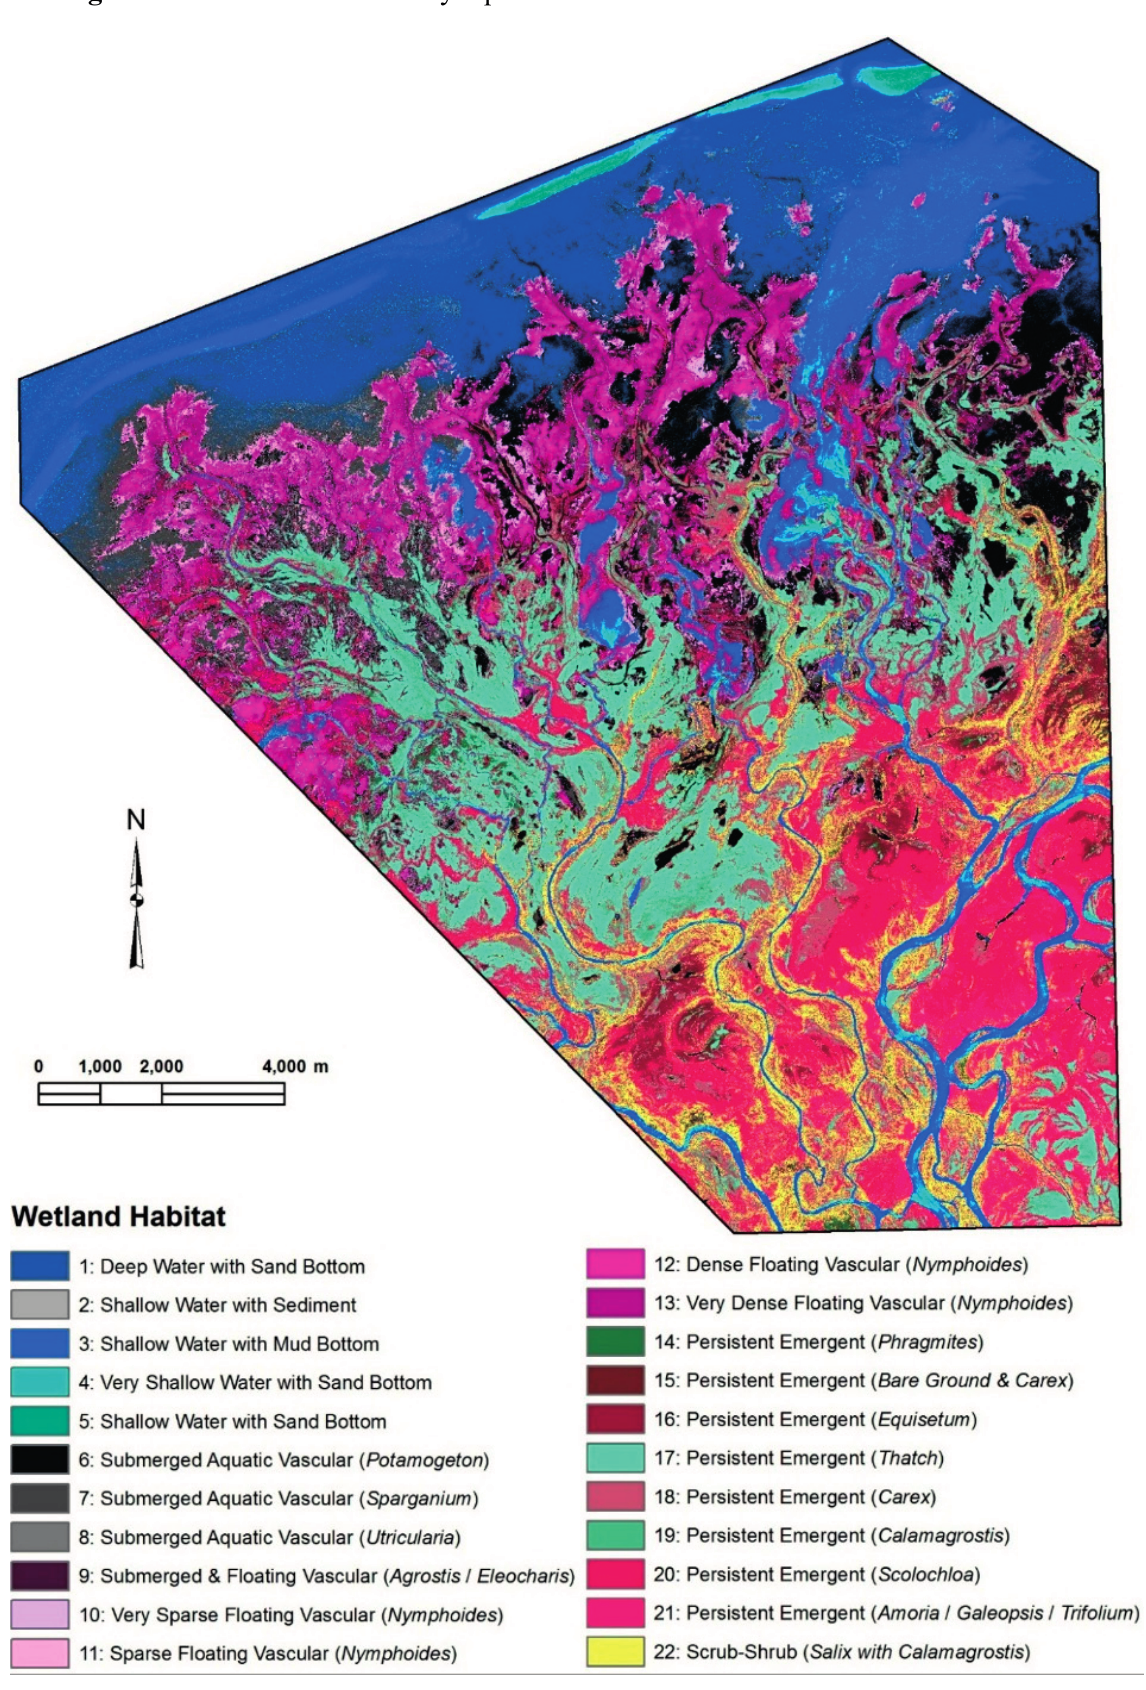
Figure 8. Genus and community aquatic and wetland habitat classification at Level